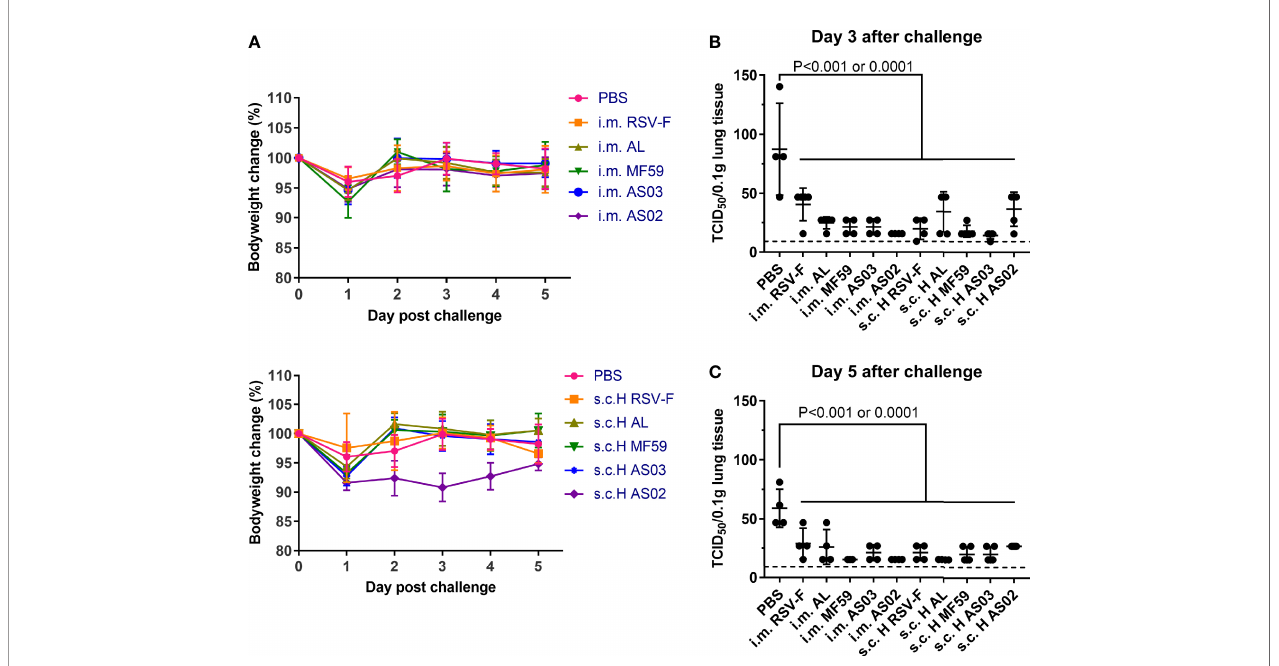
FIGURE 6 | Mice body weight changes and lung virus titers after RSV challenge. Immunized mice (n= 8-10) were intranasally challenged with RSV/A/long at week 3 after boosting. (A) Bodyweight was monitored daily after the challenge until the mice were euthanized. (B, C) Lung virus titers were assessed by TCID 50 assay on day 3 or 5 post-challenge. Each data point represented an individual animal. Dashed lines indicated limit of detection with a value of 9. Statistical signi fi cance was performed by two-way ANOVA with Tukey ’ s multiple comparisons test in GraphPad Prism. Groups that were signi fi cantly different from PBS group were marked with